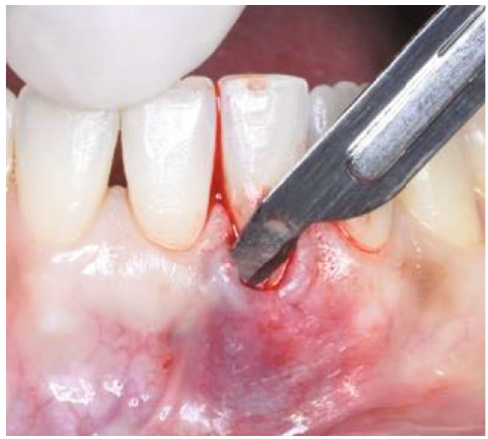
Figure 3: Intrasulcular incision preserving the interdental papillae.